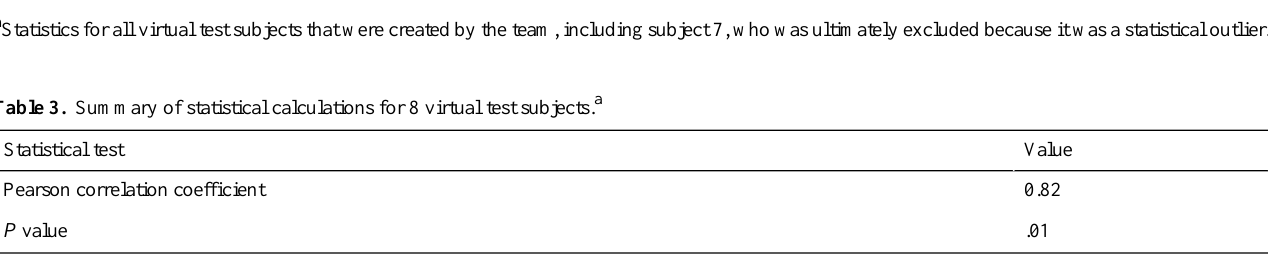
Table 4. Summary of statistical calculations for 8 virtual test subjects on the second iteration of the irregular cycle feature. a